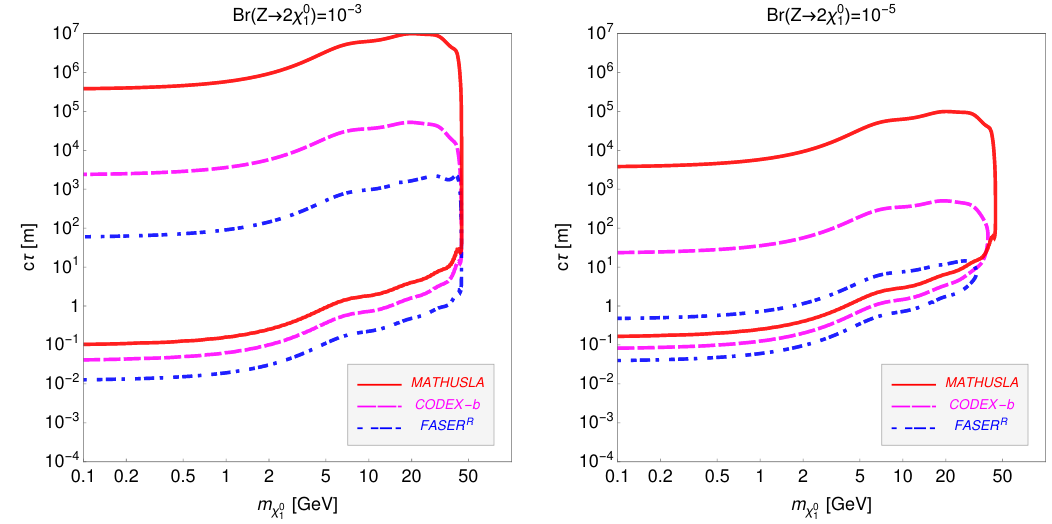
Figure 5 . Parameter space accessible for CODEX-b, FASER R and MATHUSLA for the lightest neutralino in R-parity violating SUSY. This calculation assumes neutralinos are pair-produced from Z-boson decays. The plot on the left assumes Br( Z ! (cid:31) 0 experimental upper limit), the one on the right uses 10 (cid:0) 5